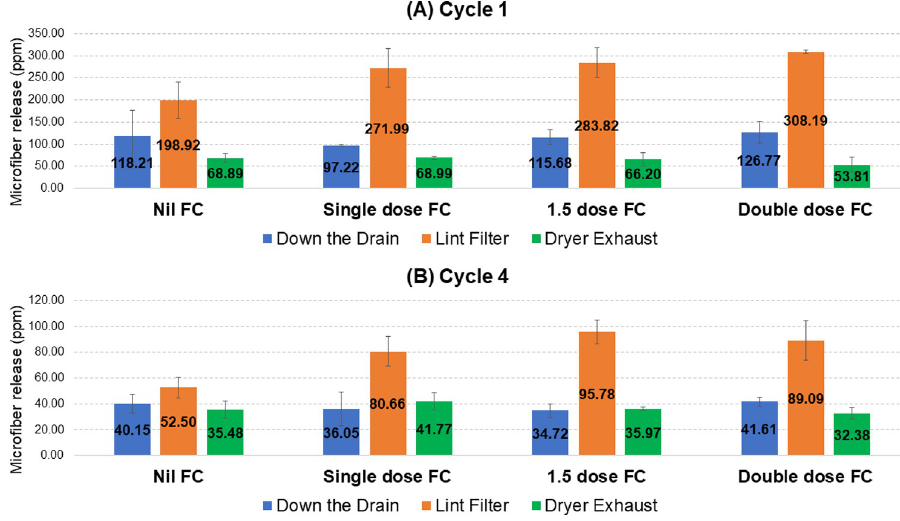
Fig 5. Microfiber release from the first and fourth cycles: Europe liquid fabric conditioner testing. Microfiber release during the first ( A ) and fourth ( B ) cycles at each of the three measurement points for all four levels of fabric conditioner (FC) is given in ppm (mg release per kg fabric). Error bars are the standard deviation.